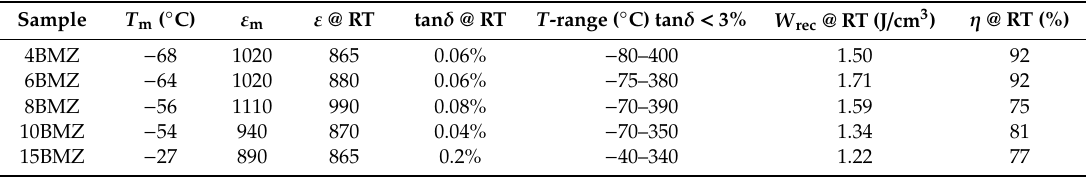
Figure 4b. The increased hysteresis may be related to the increased secondary phases. Based on the preliminary results, we chose the 6BMZ sample for further evaluation of the energy storage property.